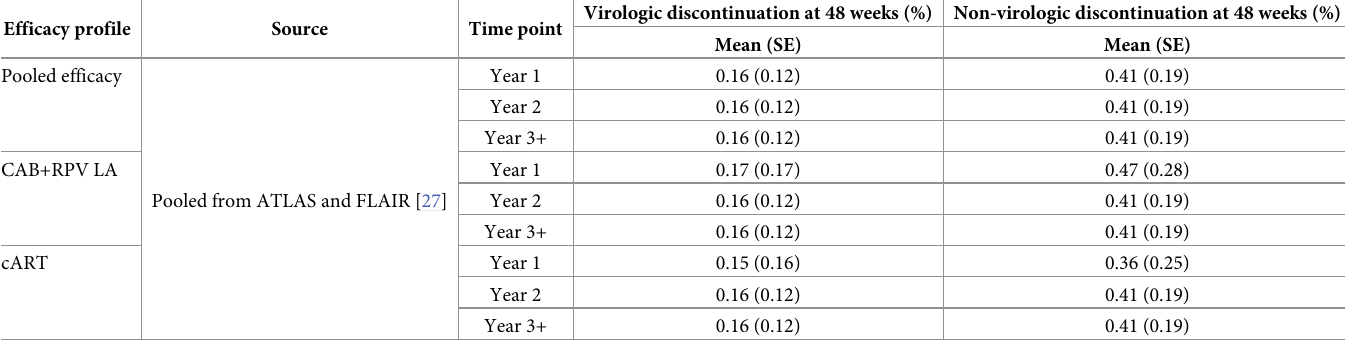
Table 2. First, second and third year onwards figures for virologic and non-virologic discontinuation. Efficacy